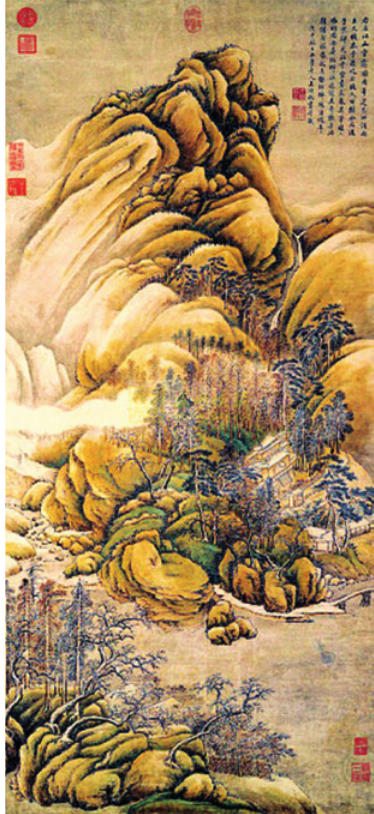
Fig. 4. Wang Shimin. After Wang Wei’s “Snow Over Rivers and